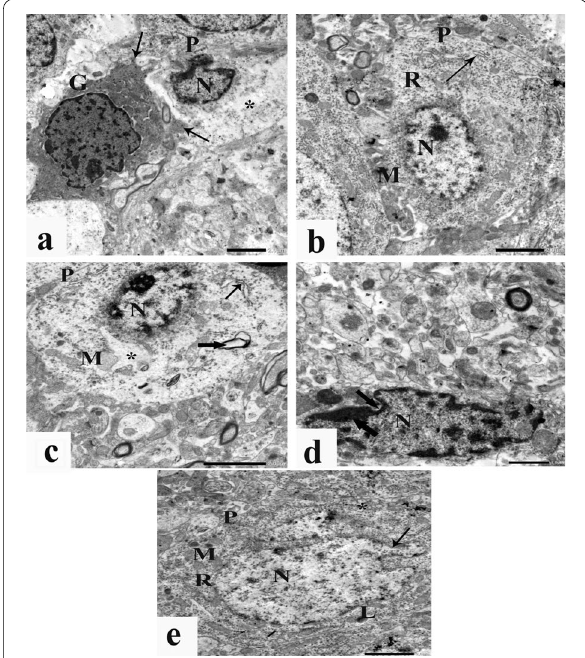
Fig.7 Electron micrographs of the cerebral cortex obtained from the reserpine- treated group showing a : necrotic pyramidal cell (P) with pyknotic nucleus (N), rarified cytoplasm (*), and apoptotic granule cell (G) with small blebs (arrows). b & c : pyramidal cell (P) with karyolissed nucleus (N), vesicular rough endoplasmic reticulum (thin arrows), scanty free ribosomes (R), degenerated mitochondria (M), electron-lucent vacuoles (thick arrow) and rarified cytoplasm (*). d & e apoptotic pyramidal cells with intended oval nuclei (N), chromatin condensation; margination and clumping with electron dense heterochromatin (thick arrow), irregularity of nuclear envelope (thin arrow), in the cytoplasm; lysosomes (L), free ribosomes (R), degenerated mitochondria (M) and distorted rough endoplasmic reticulum (*)